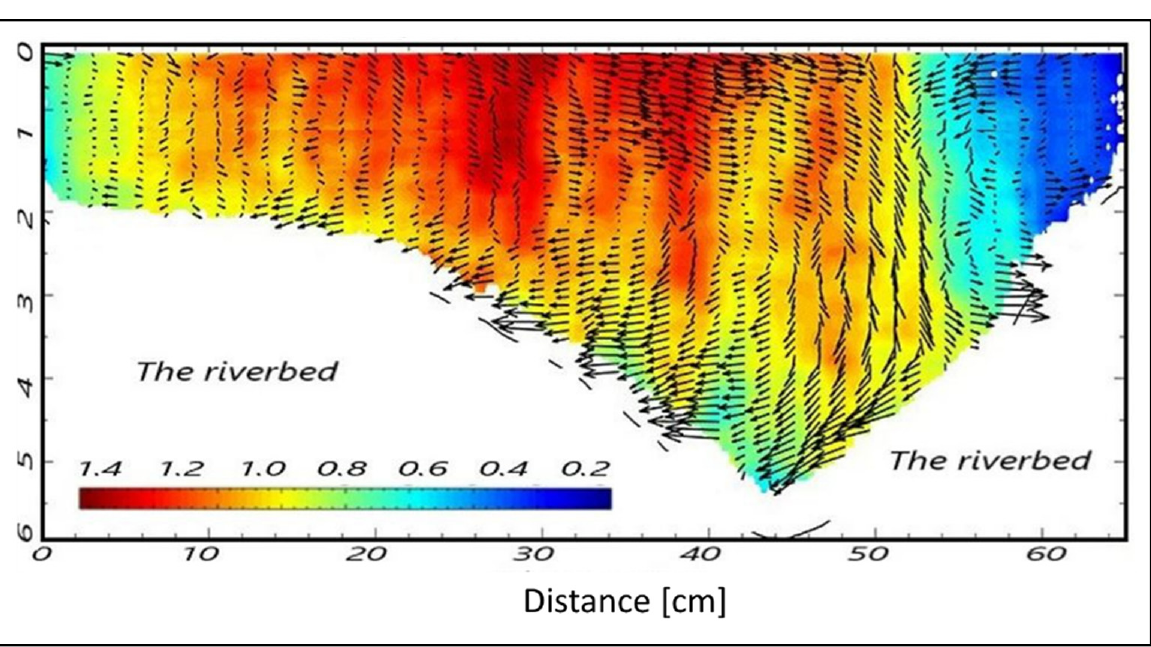
Figure 9. Detection of the riverbed and wave movements using Doppler processing for cross-section A.